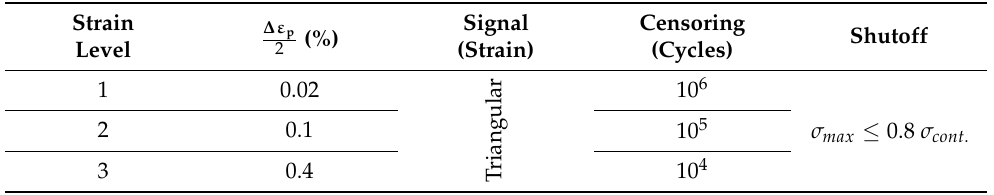
Table 2. Low-cycle fatigue test parameters. Three different levels of plastic deformation. The plastic